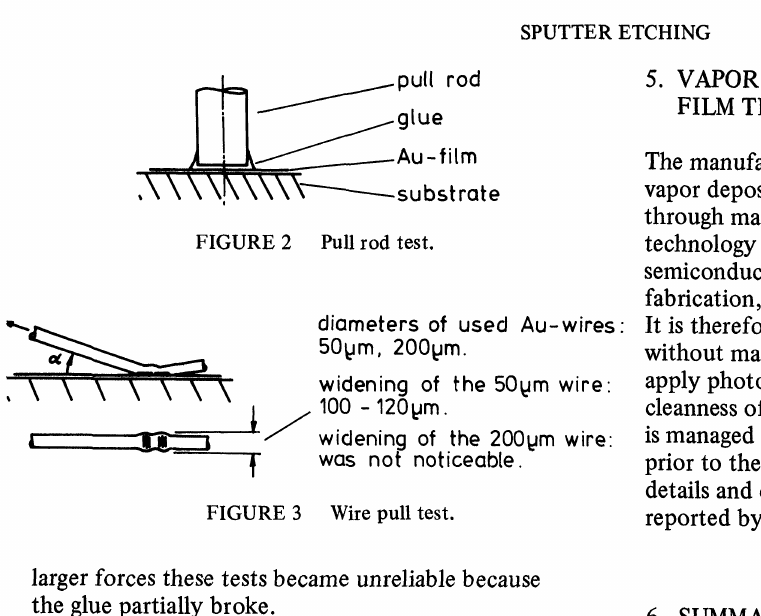
5. VAPOR DEPOSITION OF CdSe FOR